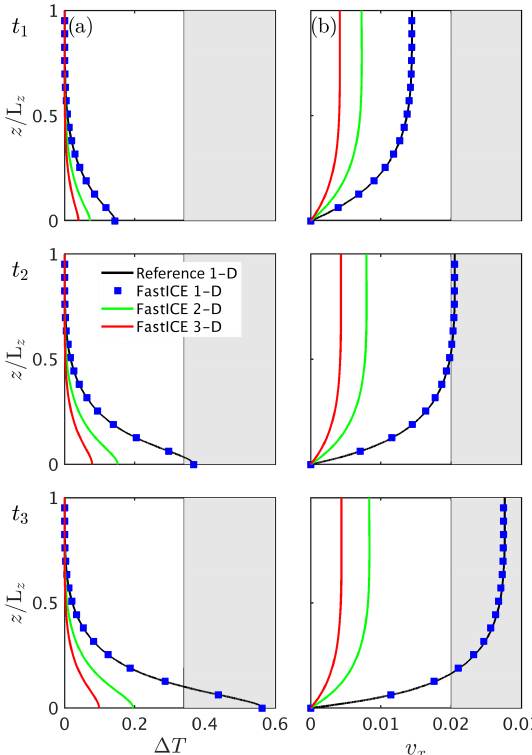
Figure 12. Non-dimensional simulation results for (a) the temper- ature deviation T and (b) the horizontal velocity component v x for the 1-D, 2-D and 3-D FastICE models at three non-dimensional times 1 × 10 8 , 2 × 10 8 and 2 . 5 × 10 8 compared to our analytical so- lution. We sample the 1-D profiles at location x = L x / 2 in 2-D and at x = L x / 2 and y = L y / 2 in 3-D. The shaded area corresponds to the part of the solution that is above the melting temperature, ap- proximately 0.35 of the temperature